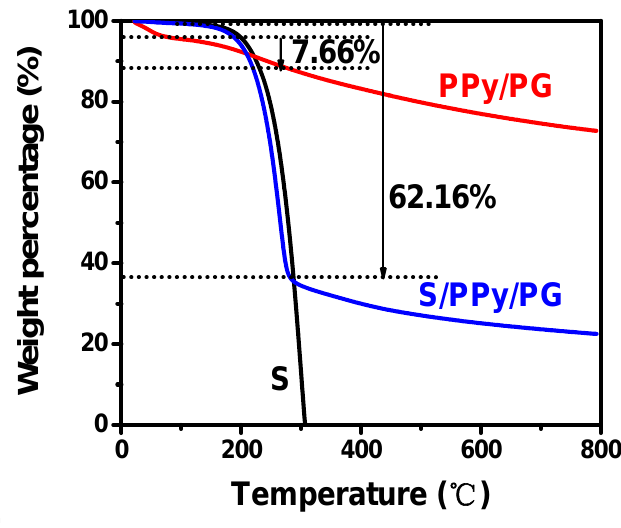
Figure 5. TGA curves of sulfur, PPy/PG and S/PPy/PG composite.